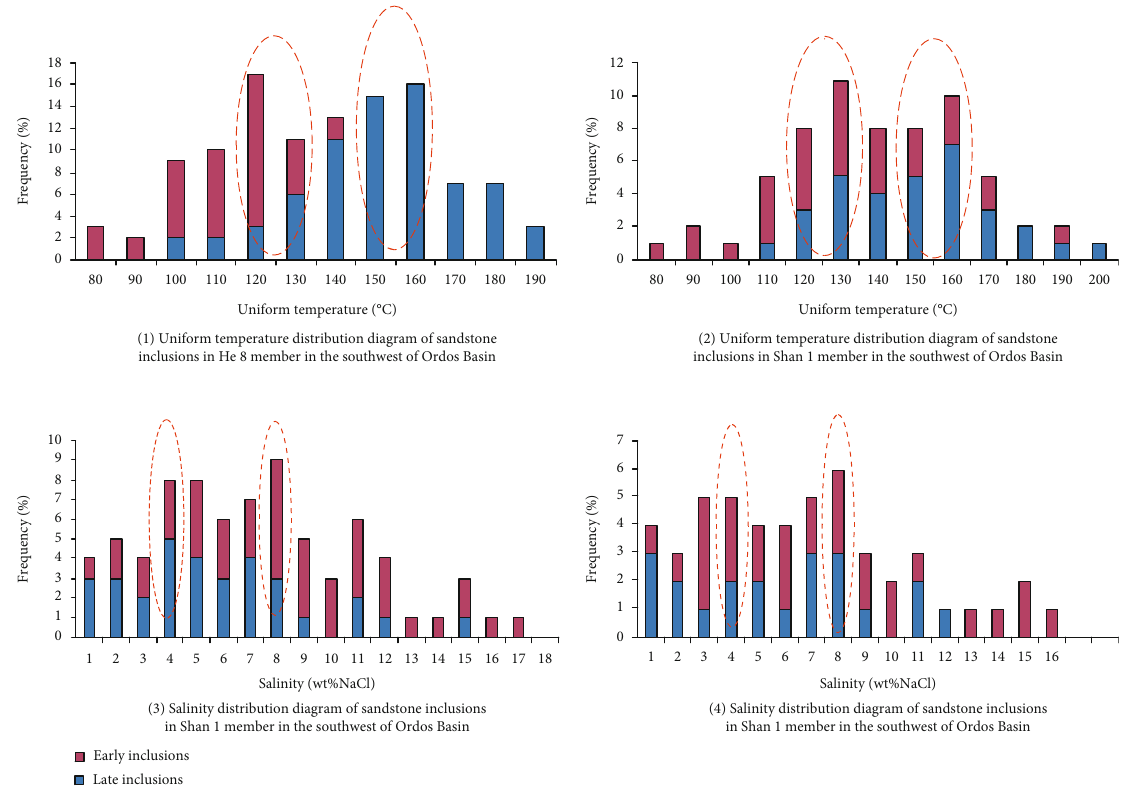
Figure 9: Homogenization temperature and salinity distribution pro fi les of sandstone inclusions in the Upper Paleozoic Erathem in the study